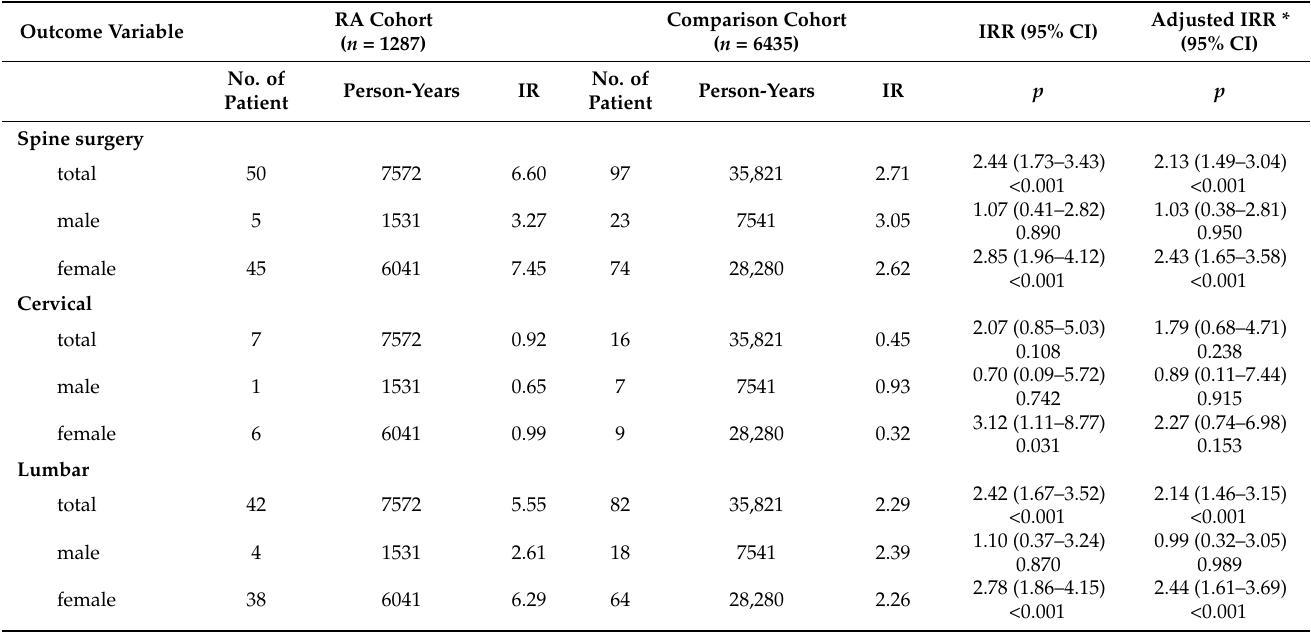
Table 2. The incidence rate and incidence risk ratio of spine surgery in the rheumatoid arthritis cohort and the comparison cohort ( n =